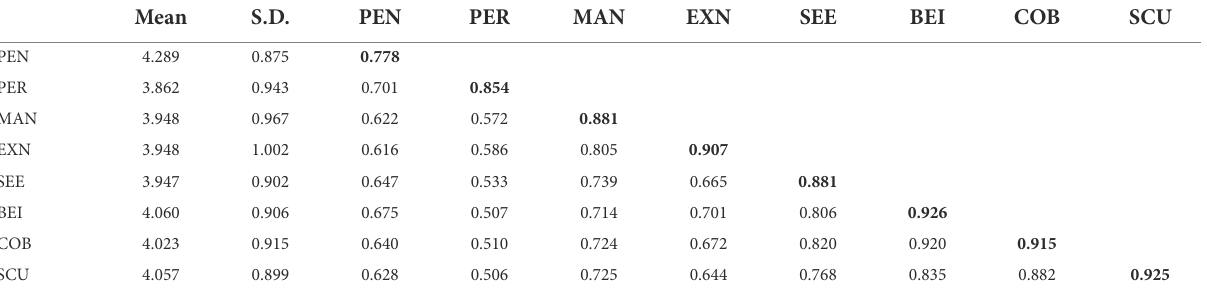
TABLE 3 Results of discriminant validity testing.